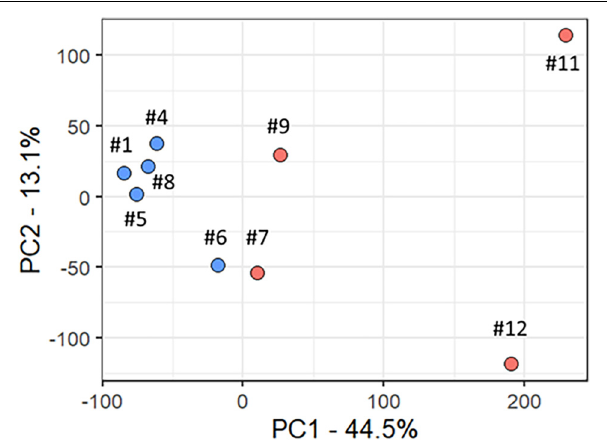
FIGURE 2 | Principal component analysis of baseline transcript profiles in participants with RTT. Scatter plot of Principal Components 1 and 2 (PC1 and PC2), which accounted, respectively, for 44.5 and 13.1% of total variance. The Responder group is shown in red and the Mecasermin Study Reference group in blue. Note that participant #6 did not meet all criteria for the Responder group; however, she also showed an improvement in her apnoea index at the end of the